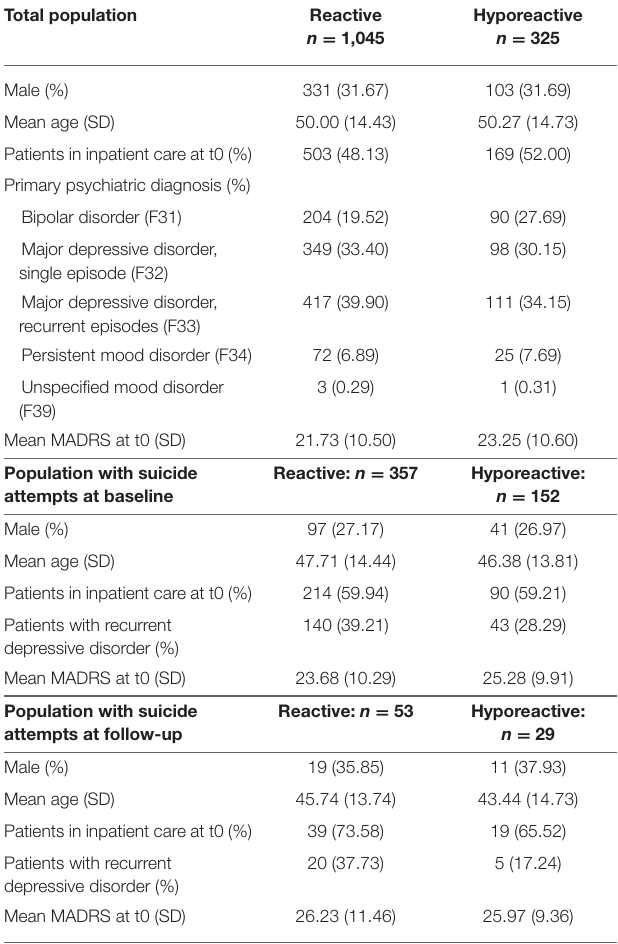
TABLE 2 | Characteristics of the study population by